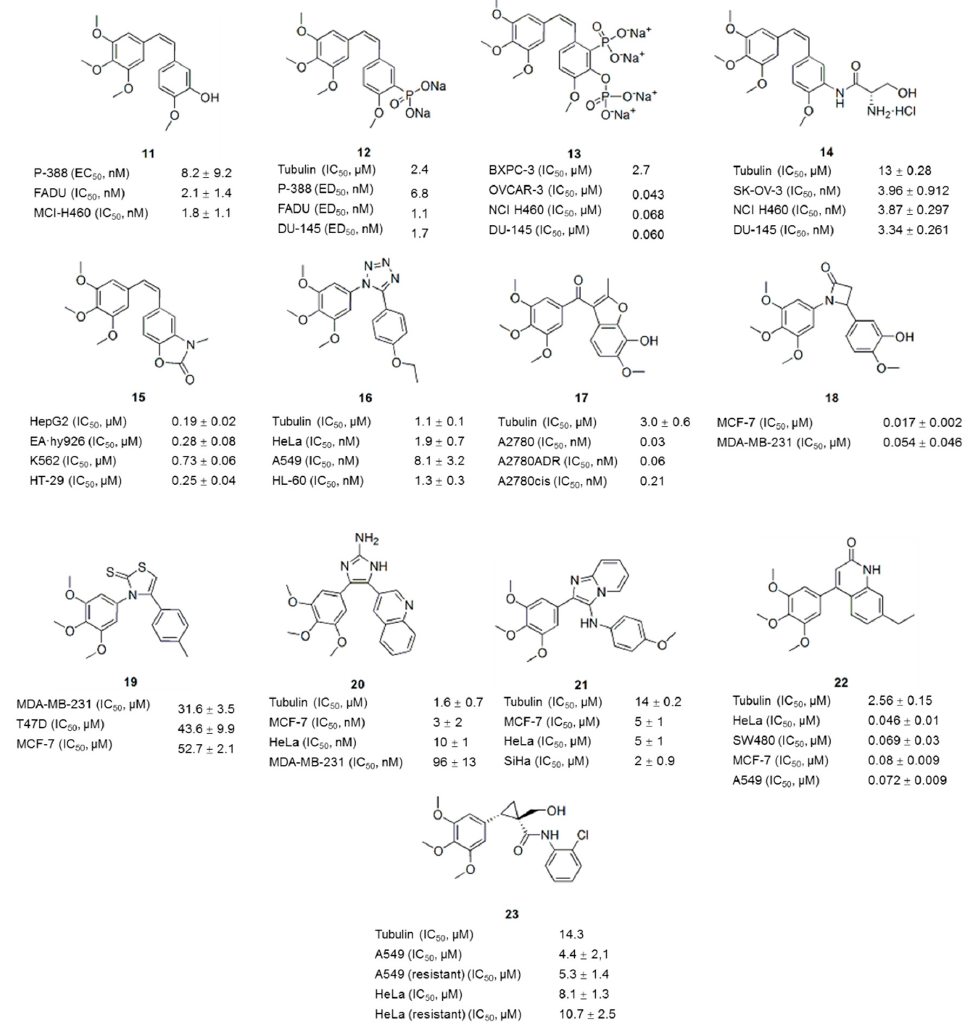
Figure 4. Combretastatin A-4 analogues.